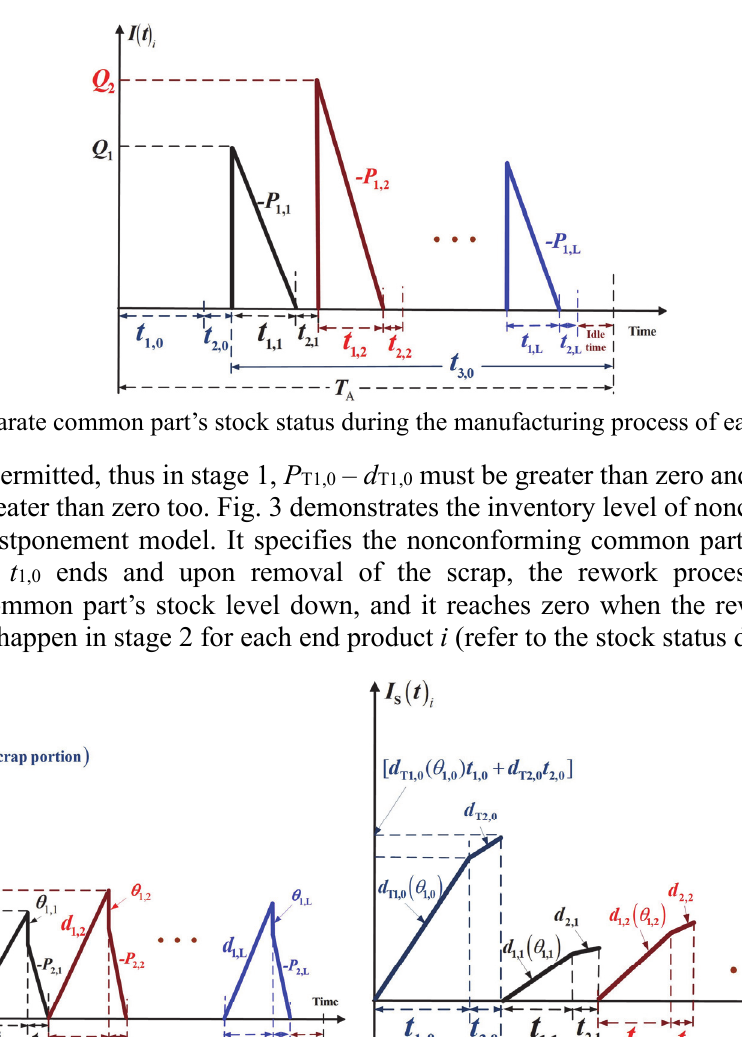
Fig. 4. The scrap stock status of this multi-item postponement